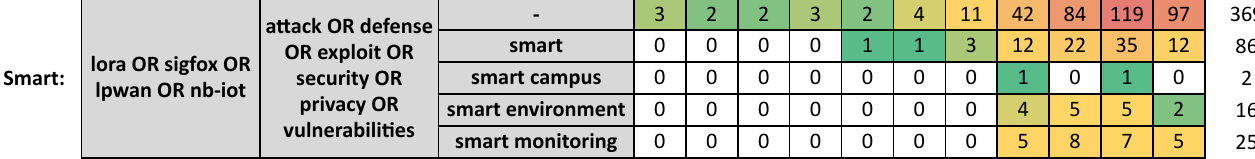
Figure 5. Systematic review results by category (“Security”, “Tech” and